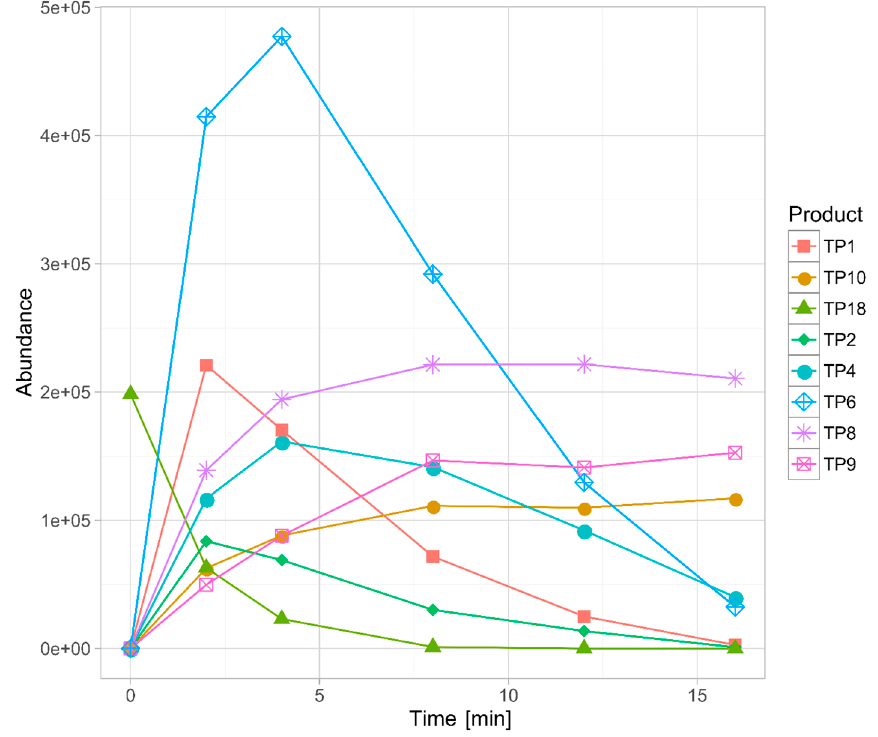
Figure 3. Evolution profiles of the TPs formed in the TiO 2